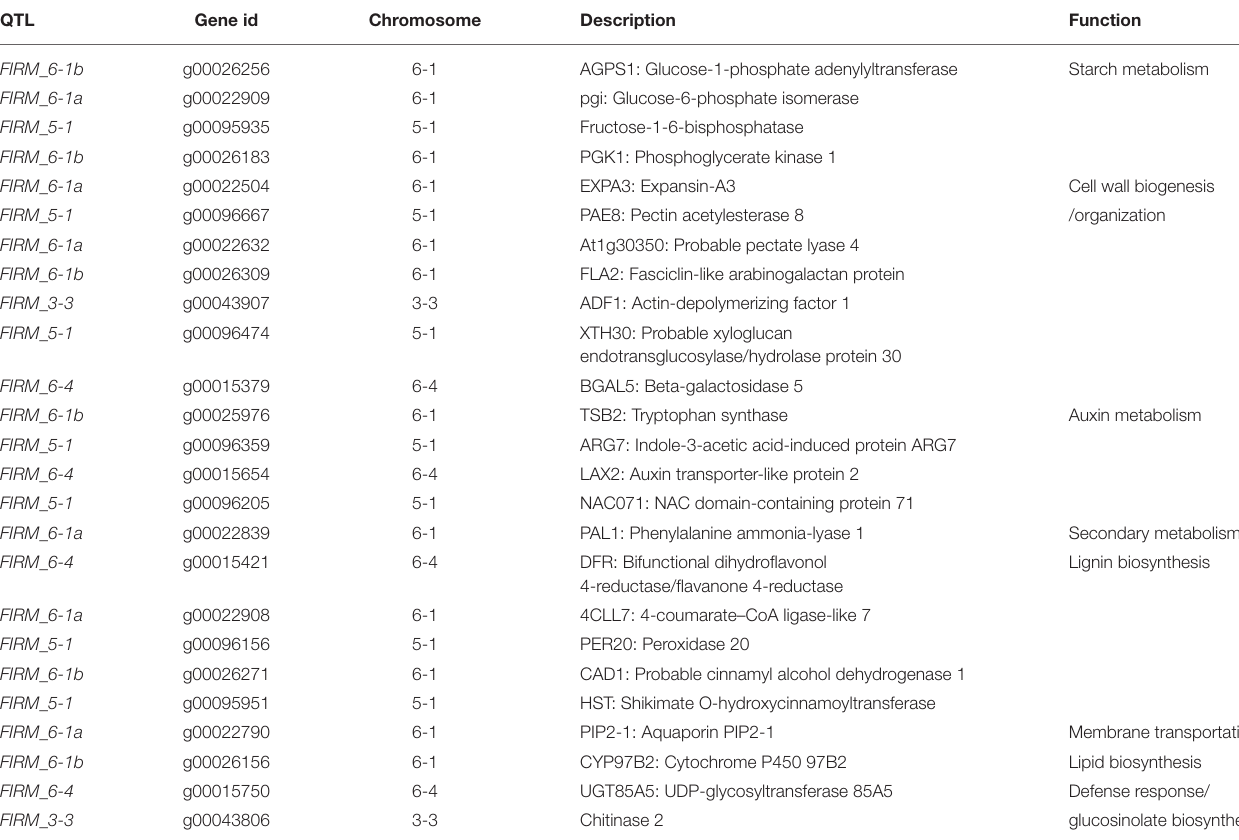
TABLE 3 | Predicted candidate genes in QTLs associated with the firmness in the ‘BS F 2 (II)’ population.